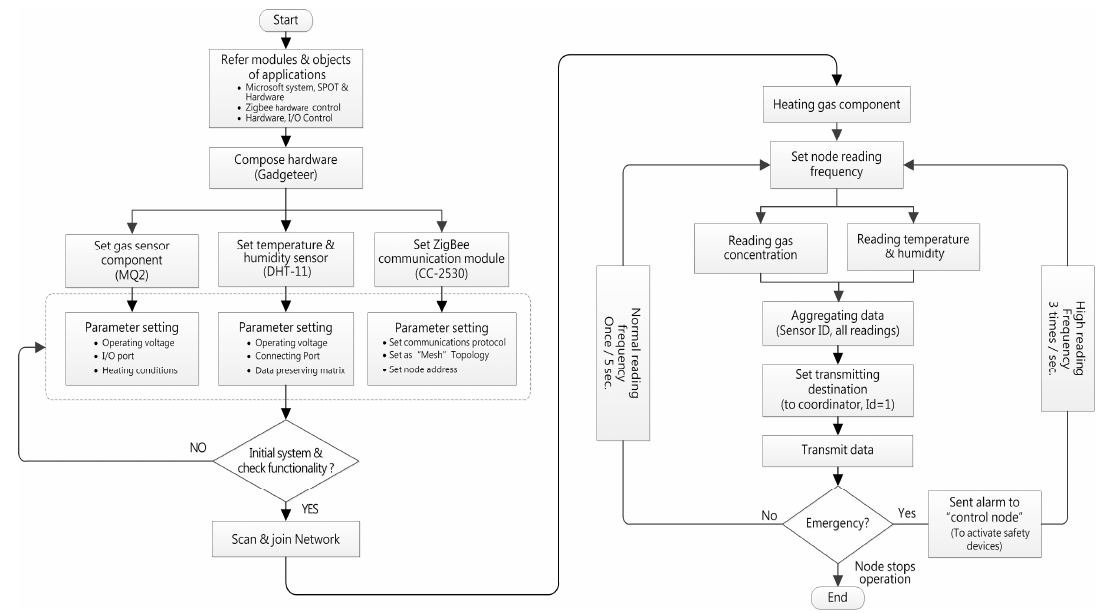
Figure 7. The flowchart of the sensor node program design.